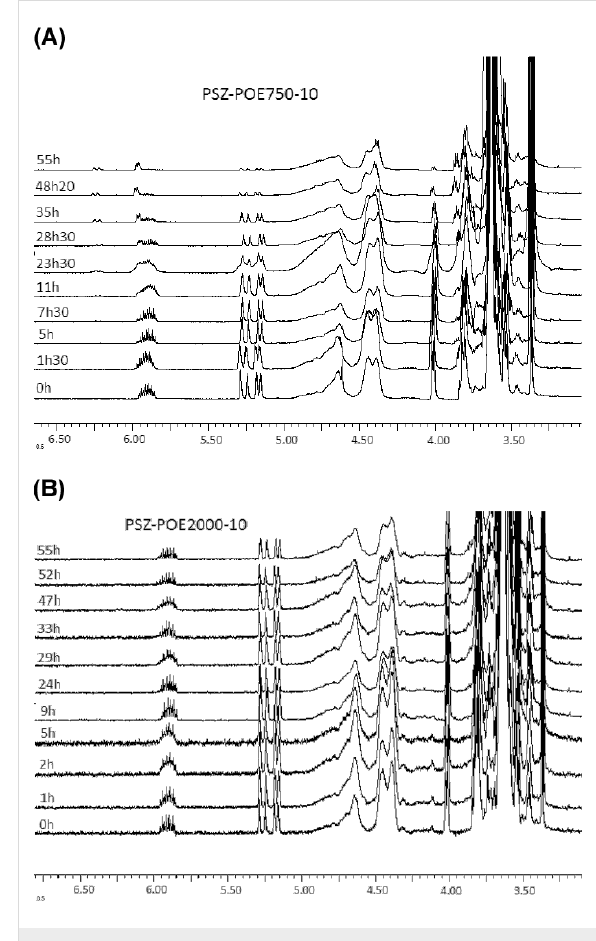
Figure 5: Investigation of grafting allyl-PEO750 (A) and allyl-PEO2000 (B) onto the PSZ chain by 1 H NMR (SiH/allyl = 10).